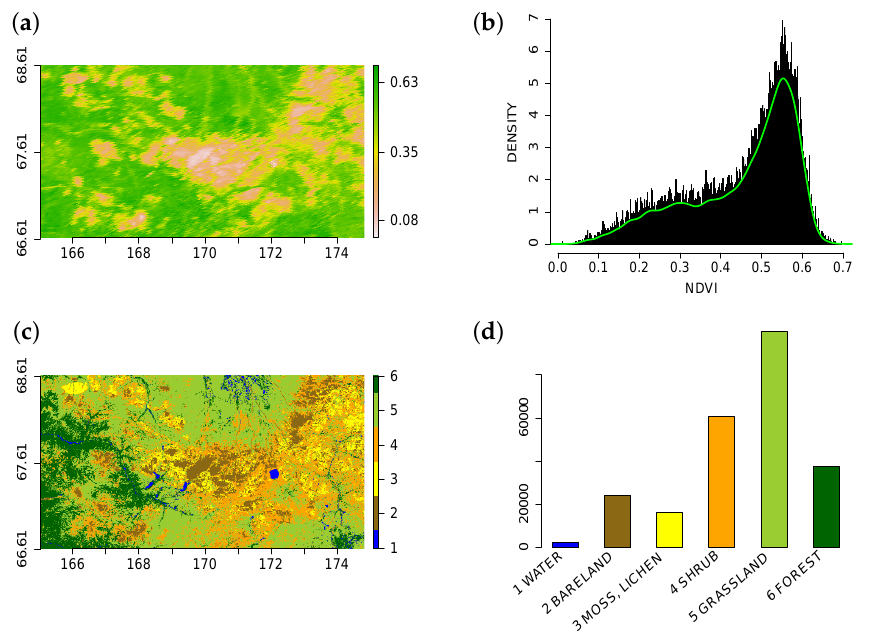
Figure 1. ( a ) Average NDVI of the growing season 2018 in the study region, ( b ) NDVI histogram with superimposed density estimate, ( c ) categorical land cover of the study region, ( d ) barplot of LCCs. Adapted from